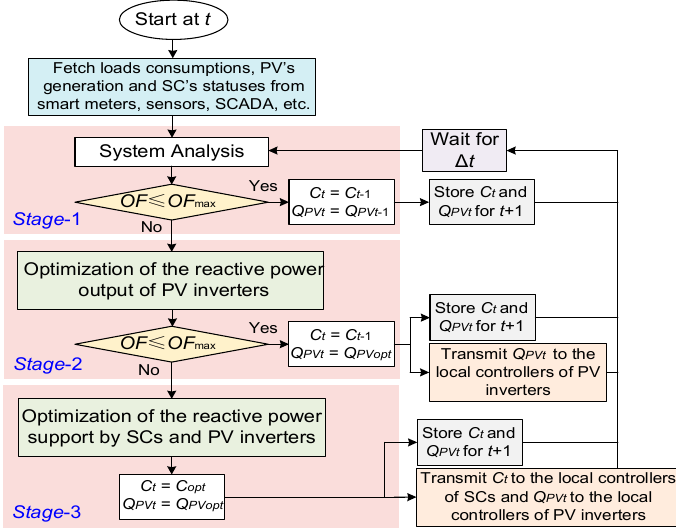
Figure 2. Flowchart of the proposed coordination strategy.